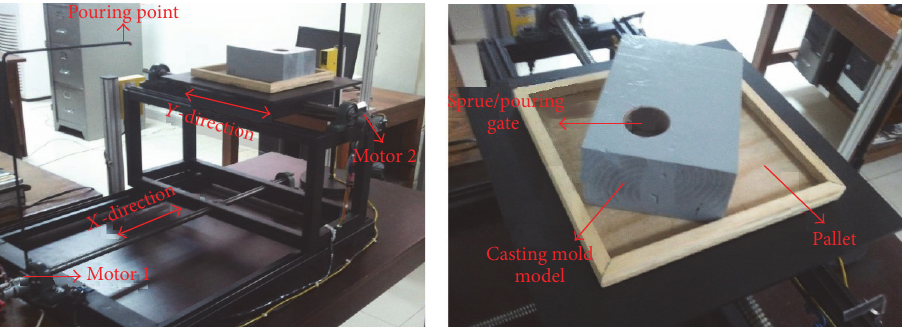
Figure 9: Mechanical model and positioning